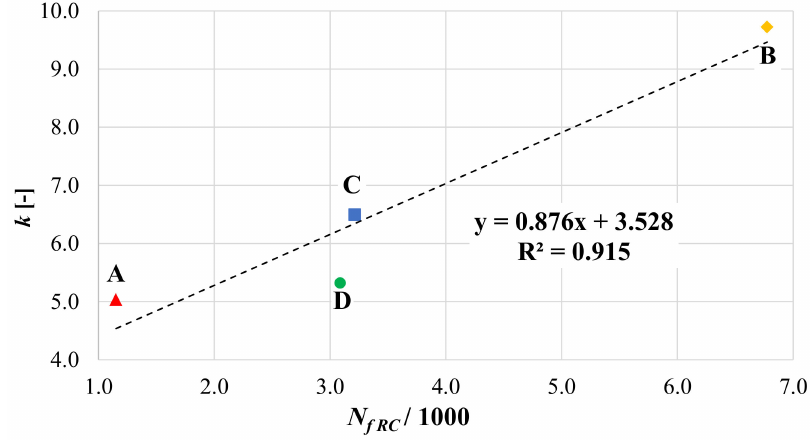
Figure 15. Correlation between the performance coefficient k and the number of cycles to failure N f RC from the reflective cracking